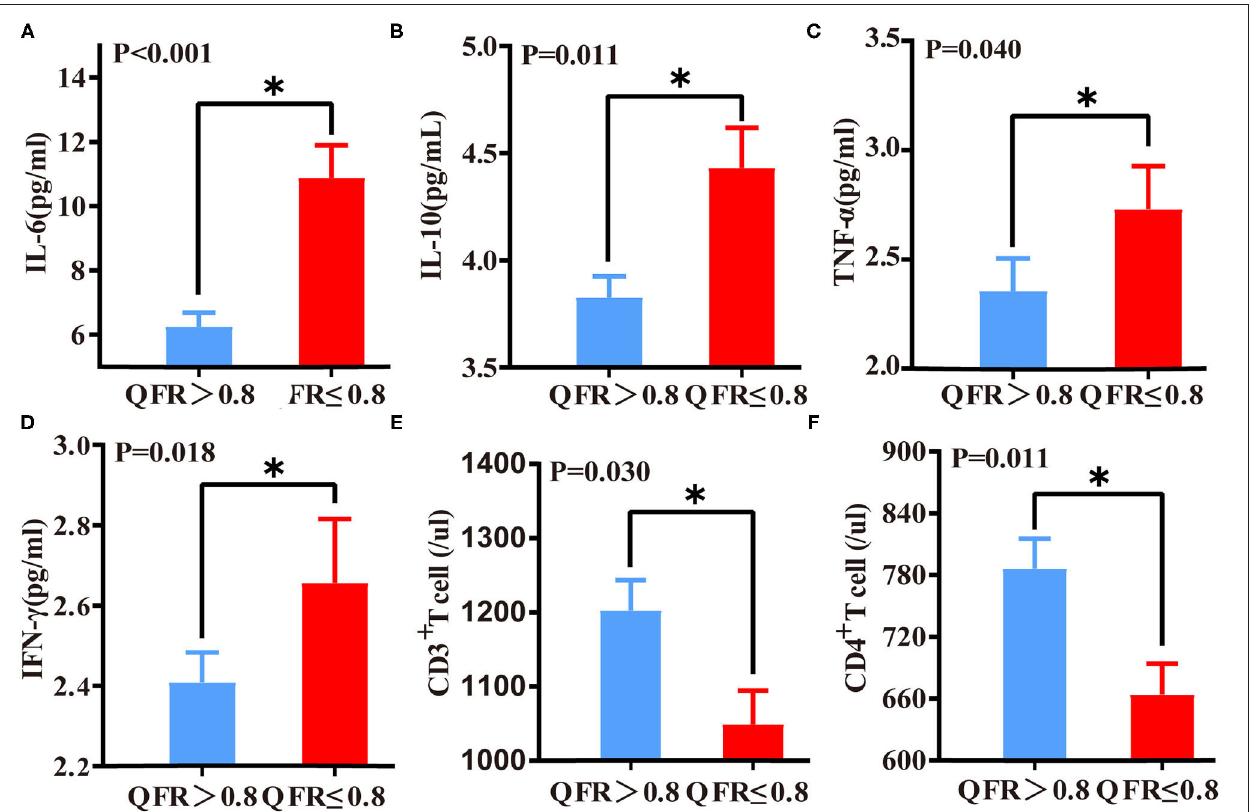
FIGURE 2 | Differences in immunoinflammatory biomarkers between QFR > 0.8 of the target vessel and QFR ≤ 0.8 of the target vessel groups. Differences in IL-6 (A) , IL-10 (B) , TNF- α (C) , IFN- γ (D) , CD3 + T lymphocyte (E) , and CD4 + lymphocyte (F) levels between the QFR > 0.8 and QFR ≤ 0.8 groups. *A p -value < 0.05 was considered a statistically significant difference between the two groups.